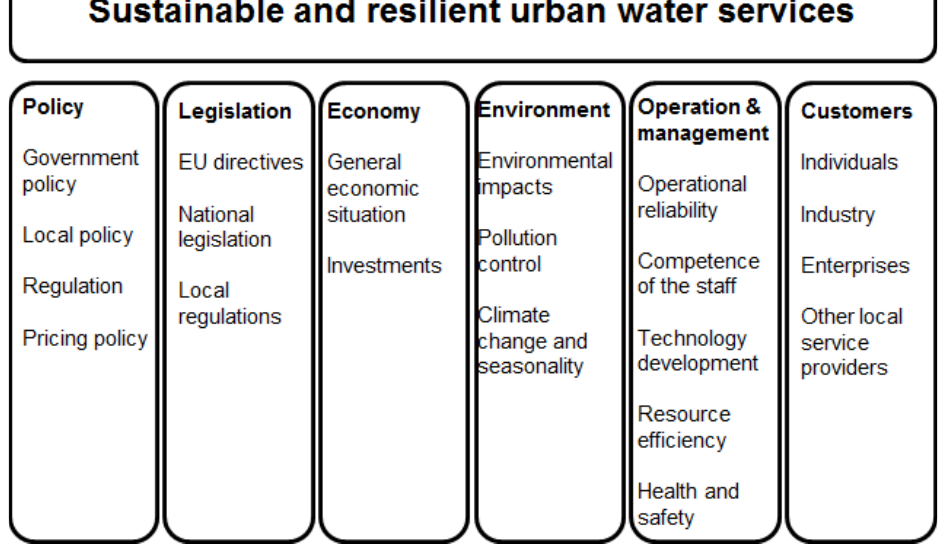
Figure 3. Pillars of sustainable and resilient water services [3].